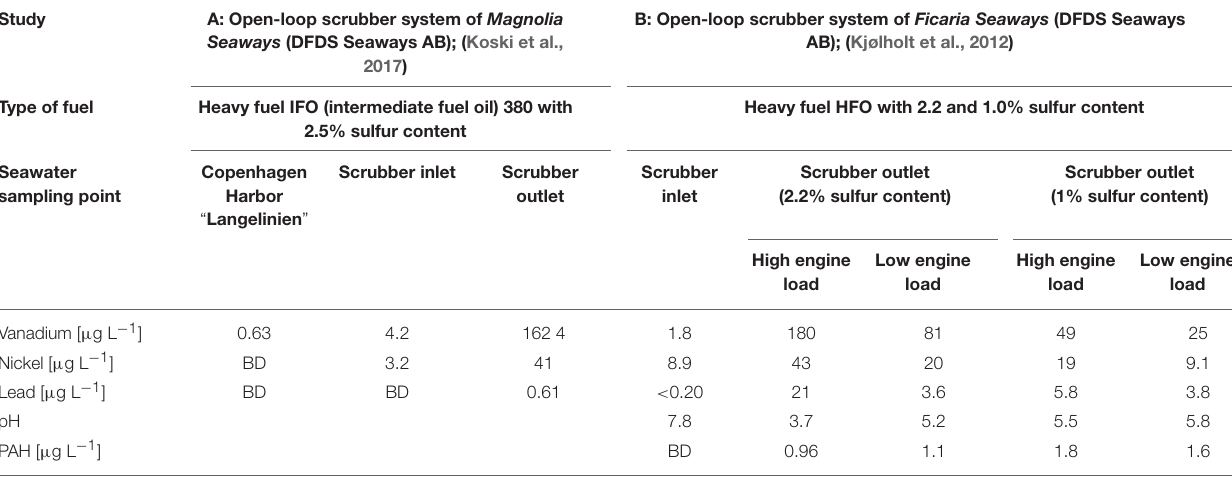
TABLE 2 | Results of the chemical analysis (pH, heavy metals, and PAH concentration) of seawater in the inlet and the outlet of open-loop scrubbers in comparison to seawater in the harbor; (BD is below detection).